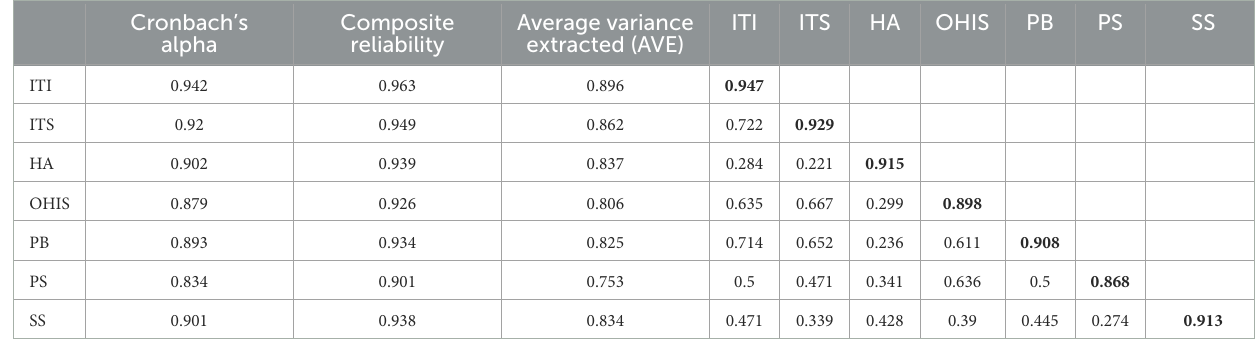
TABLE 2 Reliabilities and correlations.